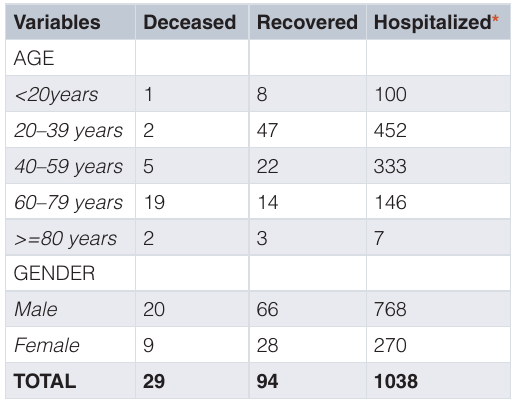
Table 2. Distribution of COVID-19 patients of India with age, gender and status of disease updated